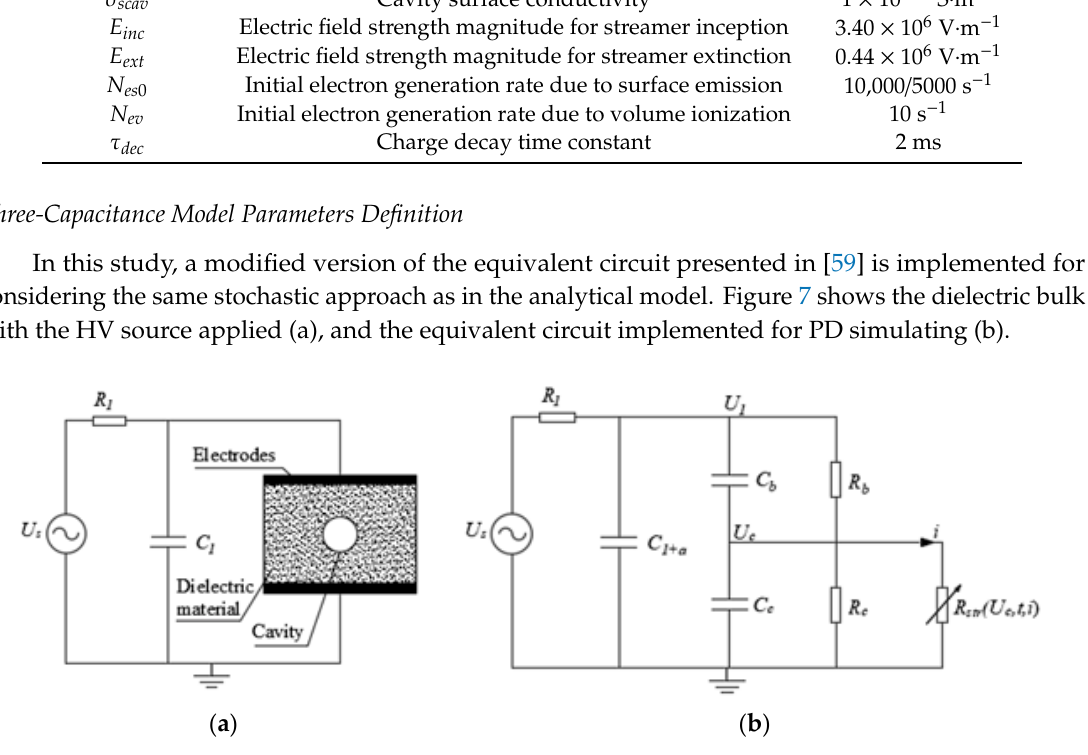
Table 8. Parameter definition for the three-capacitance model.